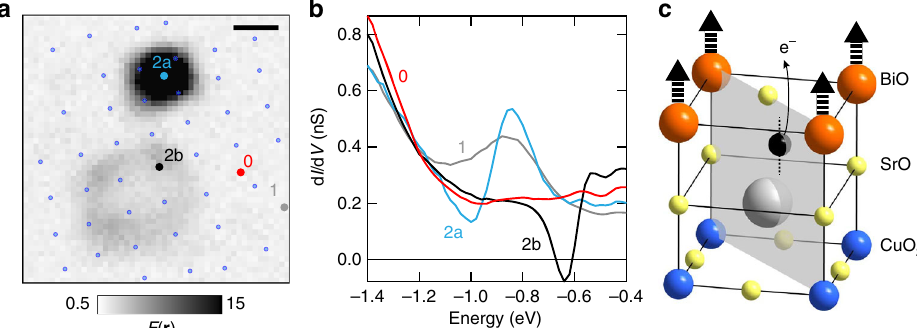
Fig. 4 All-in-one: different manifestations of defects on the same xy -location. a Fano factor on a 3 nm fi eld of view ( E = − 1.4 eV, I = 400 pA) with three different defects: one conventional (#1) and two noisy (#2a,b). A location without defect is also marked (#0). Blue dots mark the location of the Bi atoms, the scale bar indicates 0.5 nm. b Differential conductance taken at the locations indicated in ( a ). c Top three layers of cleaved Bi2212, the dopant location from ref. 19 in agreement with our data is shown in black (the dotted line through the dopant indicates possible height variations, not to scale). Weak coupling to the CuO 2 plane of some defects due to their local environment leads to charging and de-charging that modulates the current through the main conduction channels — for the bottom defect in ( a ), this is through the four neighbouring Bi atoms as indicated by the thick